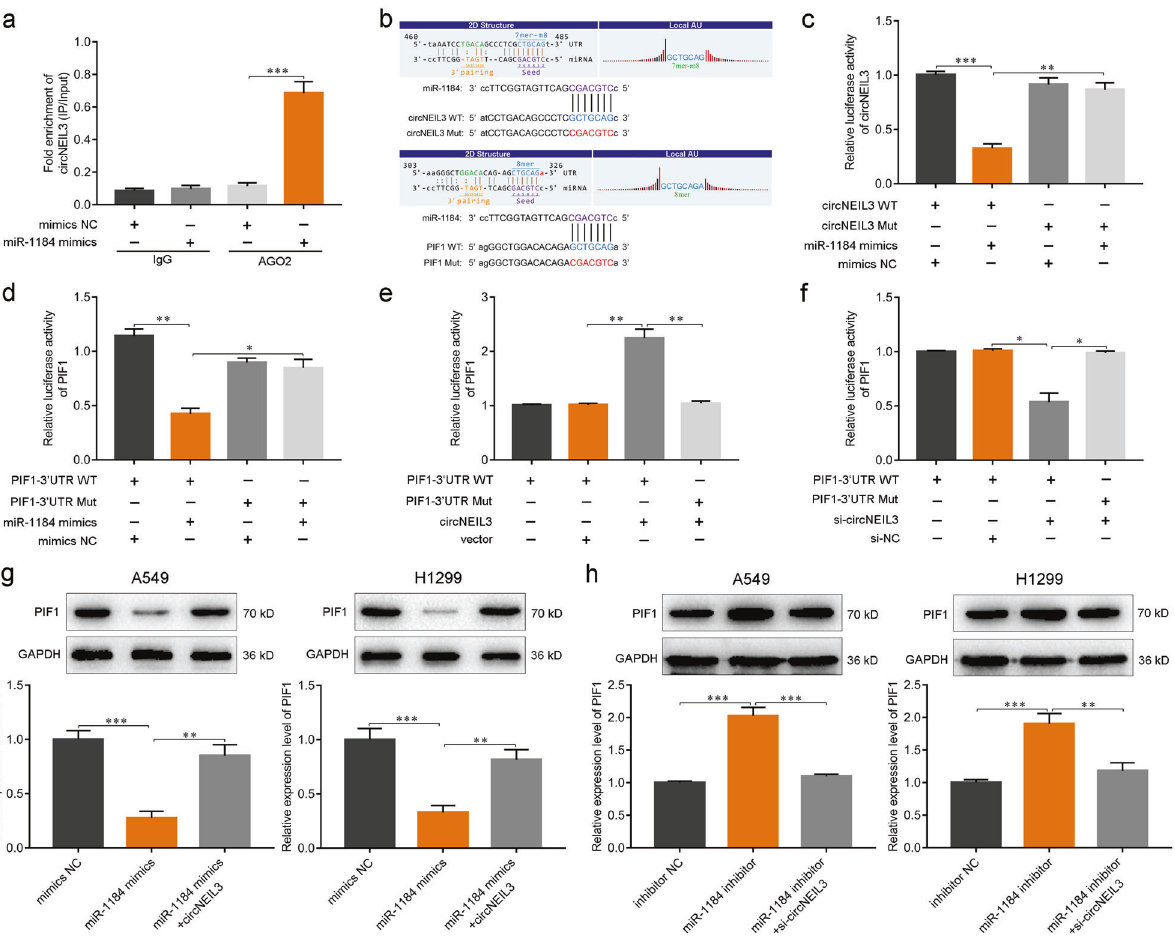
Fig. 5 circNEIL3 regulates PIF1 expression via directly binding miR-1184. a RNA immunoprecipitation performed using AGO2 antibody in A549 cells transfected with miR-1184 mimics or negative control (NC) mimics, followed by the detection of circNEIL3 enrichment. b Wild-type (WT) and mutant (Mut) transcripts of circNEIL3 or the PIF1 3 ′ -untranslated region (UTR) for luciferase reporters. c , d Dual luciferase reporter activity of circNEIL3 c and the PIF1 3 ′ -UTR d in A549 cells co-transfected with either miR-1184 mimics or NC mimics. e , f Dual luciferase